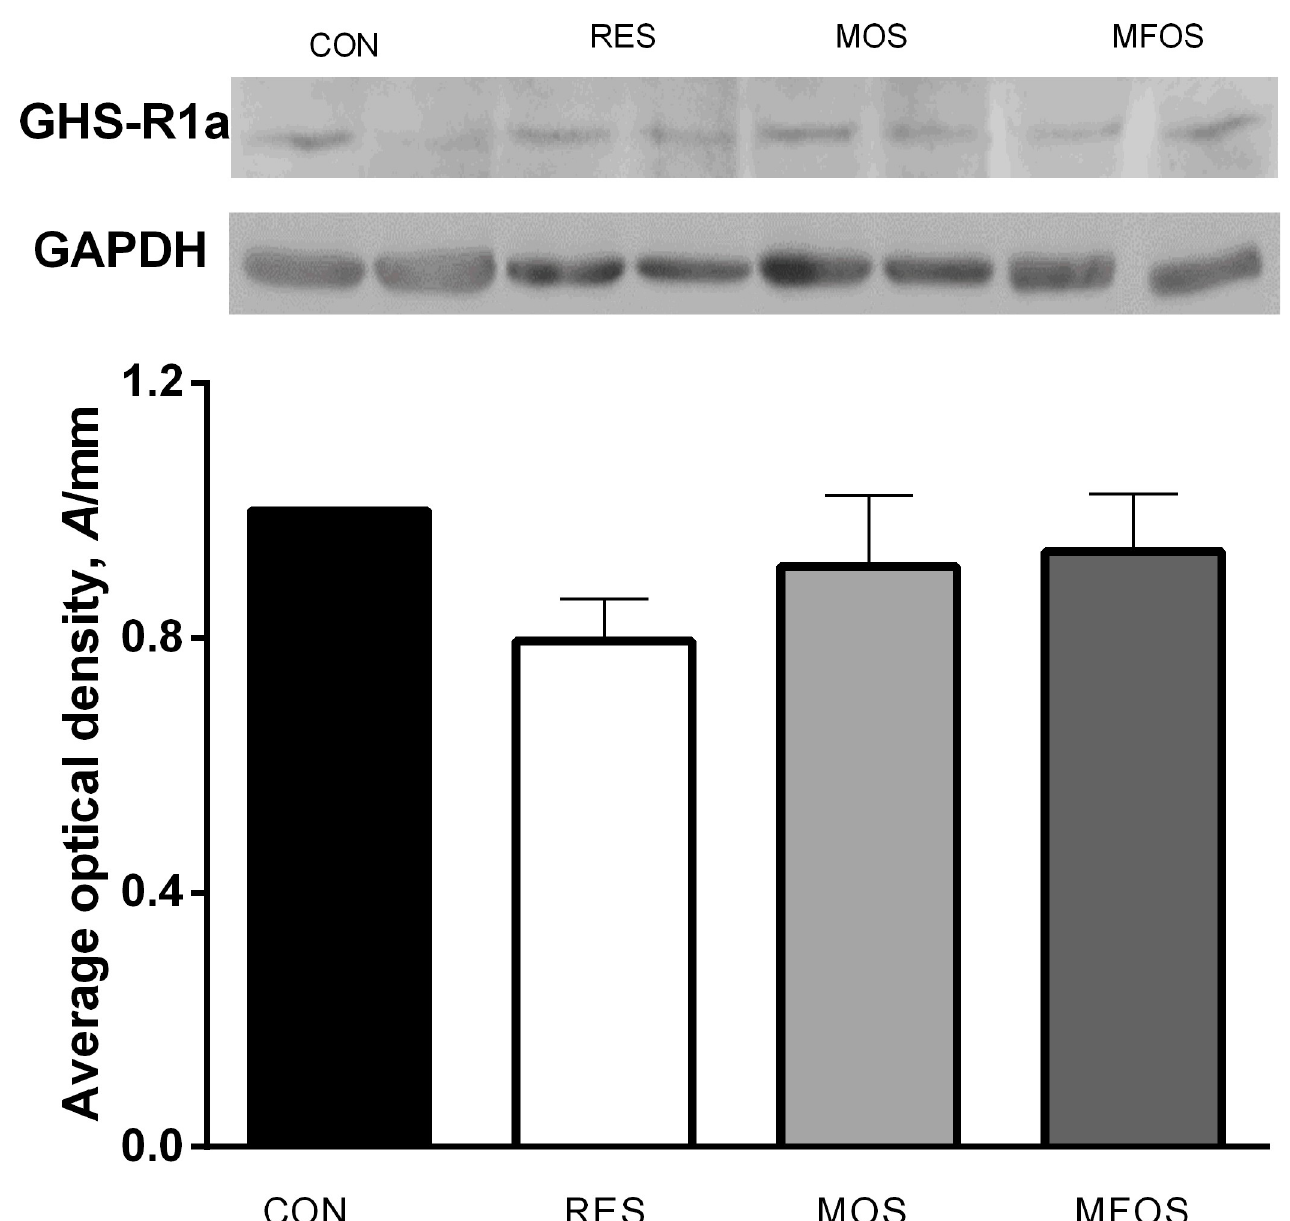
Fig 5. Gene expression of ghrelin in hypothalamus of calves. Expression of ghrelin receptor (GHS-R1a) in the paraventricular region of the hypothalamus of calves underwent milk restriction or supplemented with prebiotics. Values are presented as mean ± standard error. CON–control calves that received 6 L of milk/day for 56 days. RES–calves received restriction milk (3 L/day) for 28 days (Period 1) followed by 6 L milk/day for 28 days (Period 2). MOS–calves supplemented with 5 g/day of mannanoligosaccharides and same diet of CON animals. MOS calves supplemented with 5 g/day of manan- fructooligosaccharides and same diet of CON